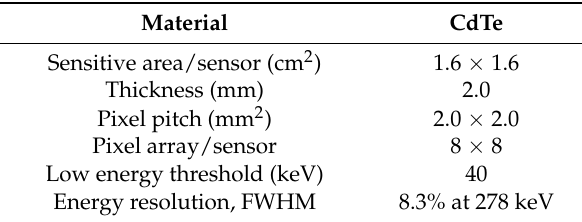
Table 2. Summary of the main characteristics of the Compton-PolCA